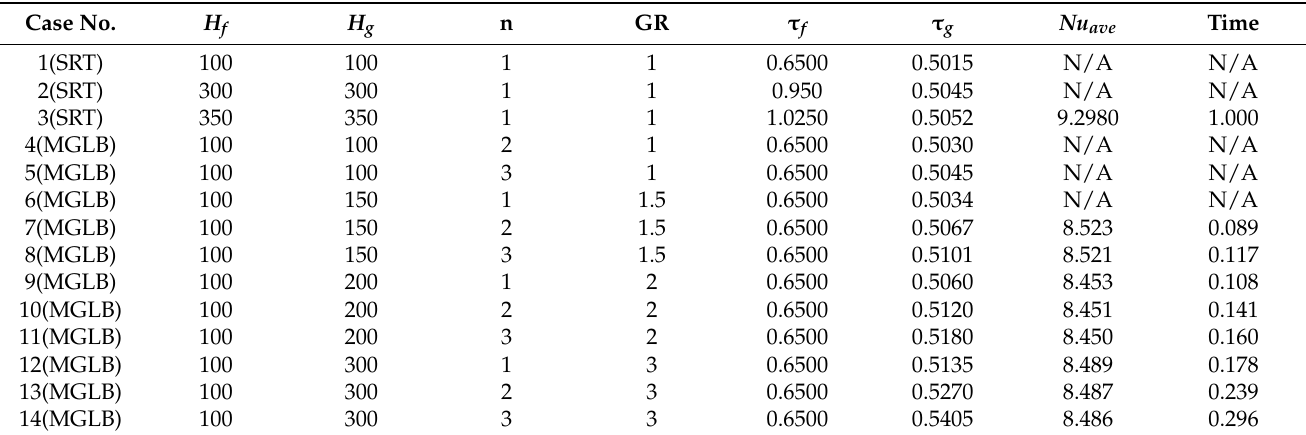
Table 5. Input parameters and simulation results for Ra = 10 6 , Pr = 100 for simulations with SRT (Cases 1 to 3) and MGLB (Cases 4 to 14). “N/A” indicates that the solution diverged. The characteristic velocity was selected as u c = 0.05 in all cases. The average Nu number from SRT-LB simulations presented in Section 3.2 was 9.240. Case No.